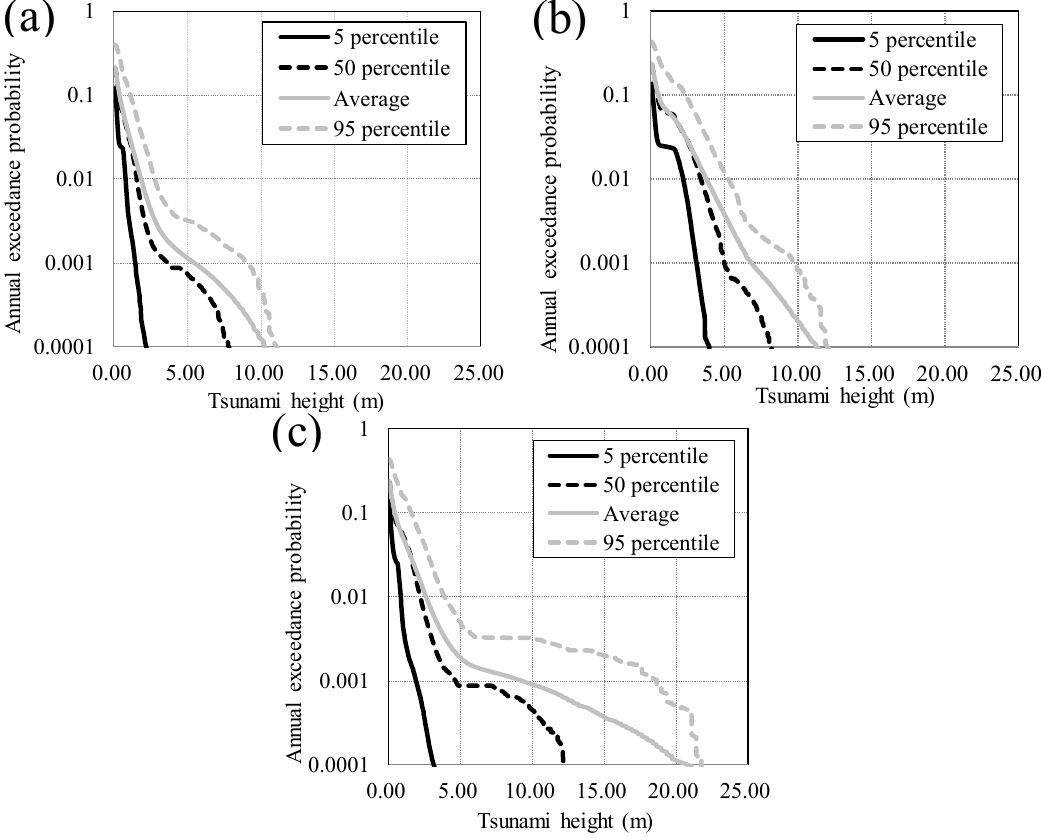
Figure 8. Relationships between the annual exceedance probability and tsunami wave height at ( a ) a water depth of 10 m (37.85127° N, 140.96812° E) off the port of Soma; ( b ) a water depth of 10 m (37.85127° N, 140.96812° E) off the coast of Sendai Plain; and ( c ) a water depth of 10 m (37.85127° N, 140.96812° E) off the coast of the city of Kesennuma.